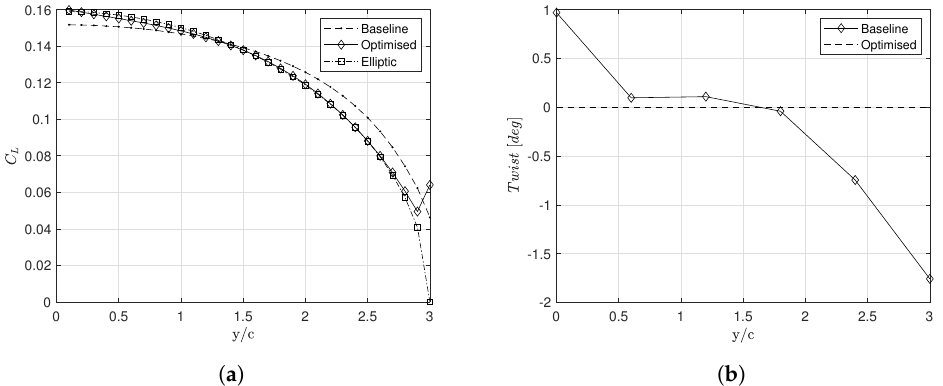
Figure 8. Lift and twist distributions for the baseline and optimised wing geometries. ( a ) Lift distri- bution. ( b ) Twist